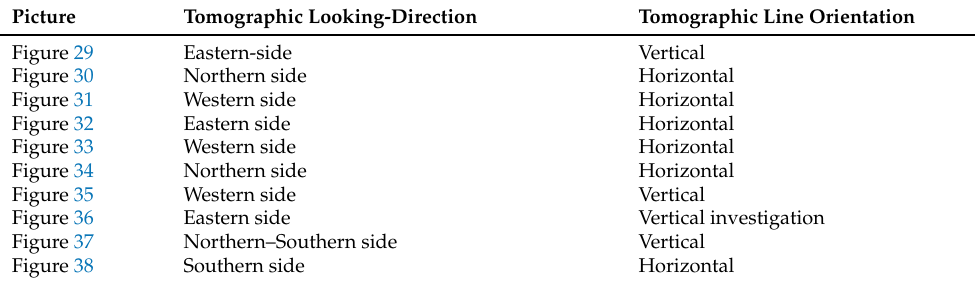
Table 5. List of the principal tomographic